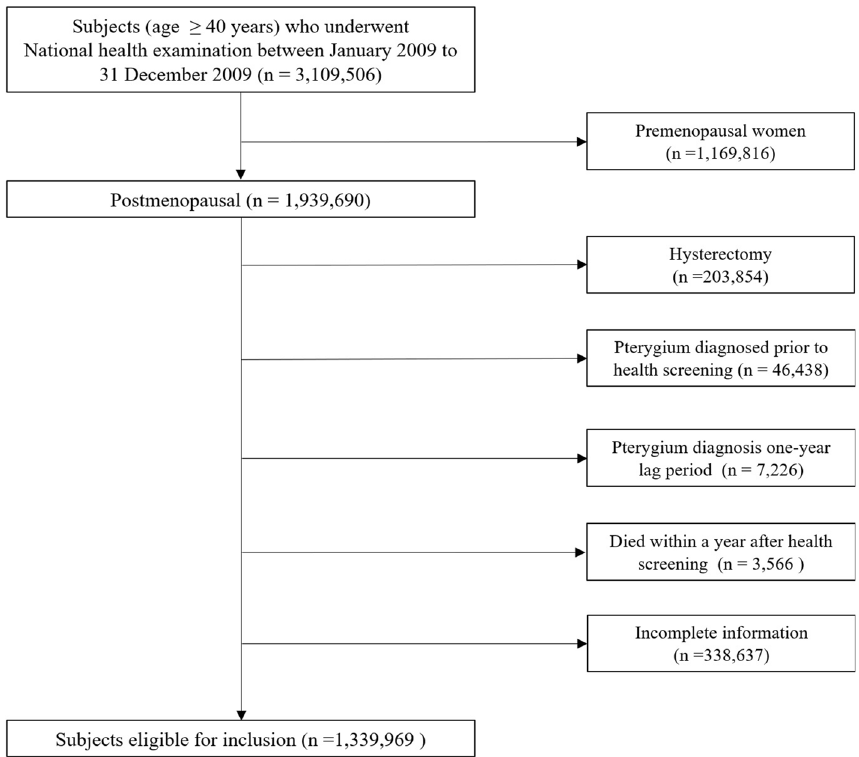
Figure 1. Flow chart of study